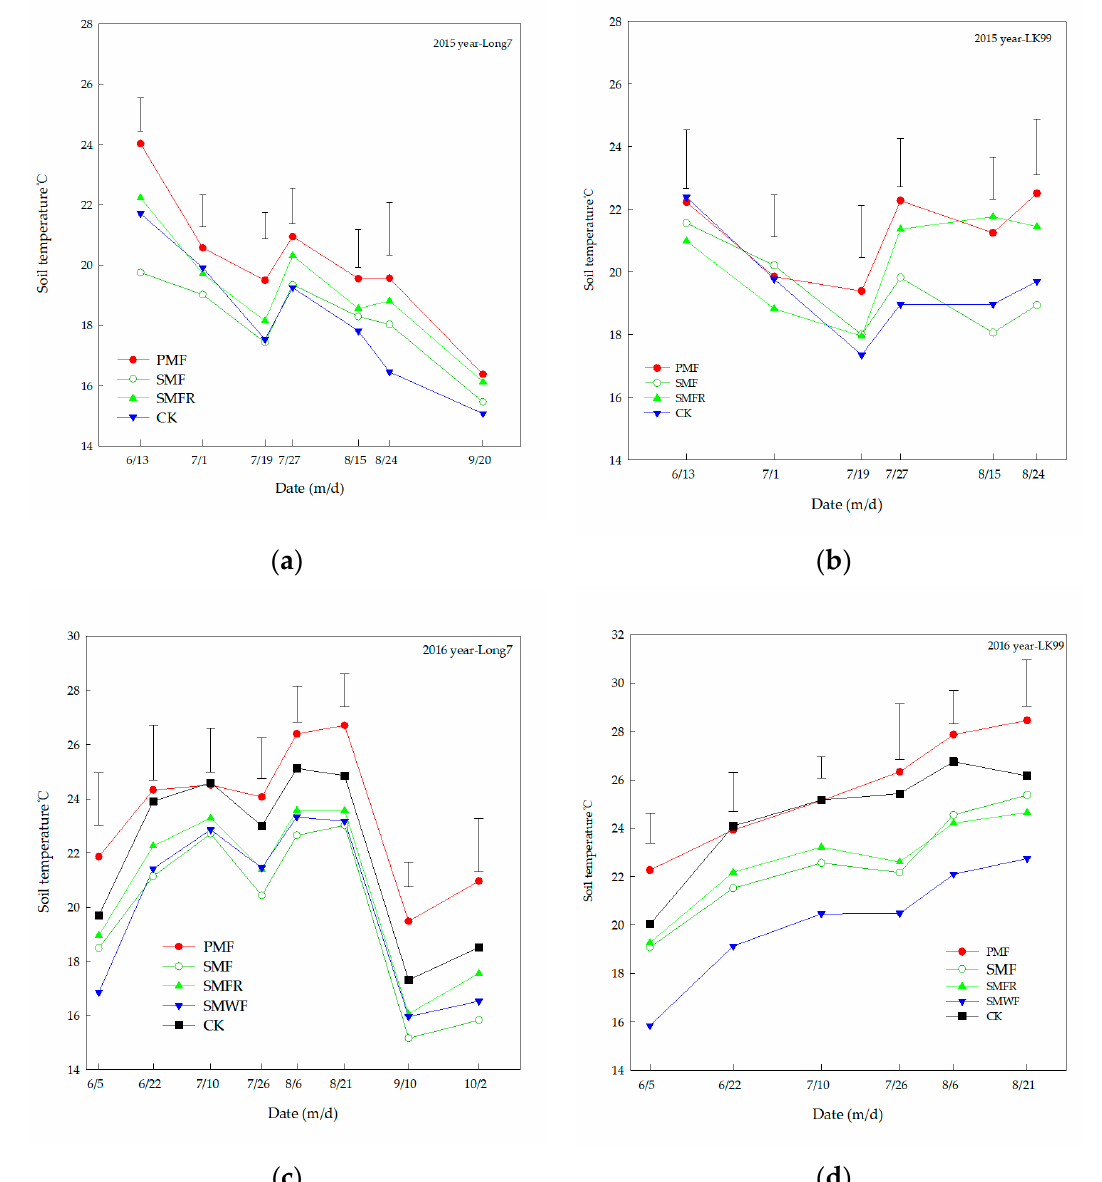
Figure 4. ( a – d ) Average soil temperature in 0–25 cm soil layers at different growth stages. ( a ) Different growth periods of late-maturing varieties (Long7) in 2015. ( b ) Different growth periods of early-maturing varieties (LK99) in 2015. ( c ) Different growth periods of late-maturing varieties (Long7) in 2016. ( d ) Different growth periods of early-maturing varieties (LK99) in 2016. The error bar indicated that there were significant differences in soil temperature among treatments at different growth stages ( p < 0.05). The length of error bar is LSD value.